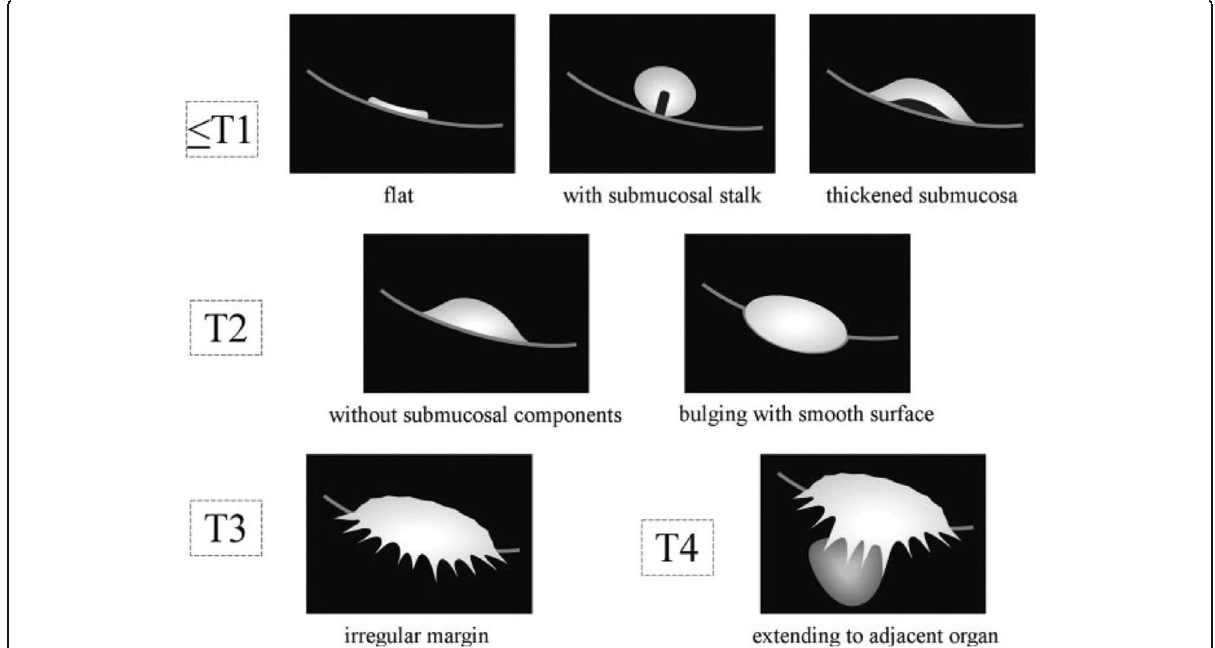
Fig. 1 Schematic diagram that shows diagnostic criteria for using diffusion-weighted imaging for staging bladder cancer. Cancer component, muscle layer, and submucosa show high, intermediate, and low-signal intensity, respectively. Submucosal stalk or thickened submucosa indicates T1 or lower stage; smooth tumor margin without submucosal components, T2; irregular margin toward the perivesical fat tissue, T3; and extension into adjacent organs, T4 [11]